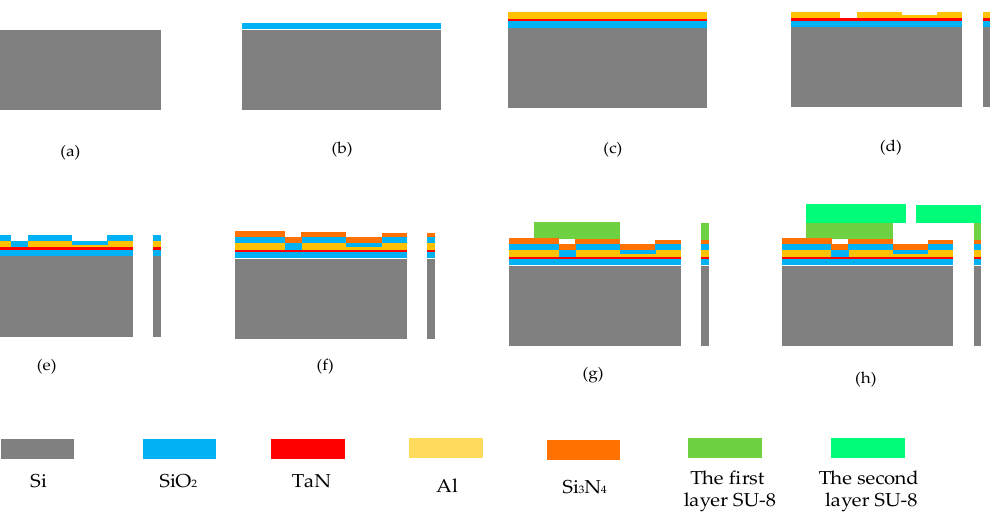
Figure 10. Manufacturing process of the thermal printing chip. ( a ) Using a bare silicon wafer as the substrate. ( b ) Using the first layer of SiO 2 as the thin layer. ( c ) Using the TaN and Al to form the heating resistors. ( d ) Etching the chip using the MEMS process. ( e ) Using the second layer of SiO 2 as the thin layer. ( f ) Using the Si3N4 as the thin layer. ( g ) Using the first layer of SU-8 photoresist to form the chamber. ( h ) Using the second layer of SU-8 photoresist to form the nozzle.